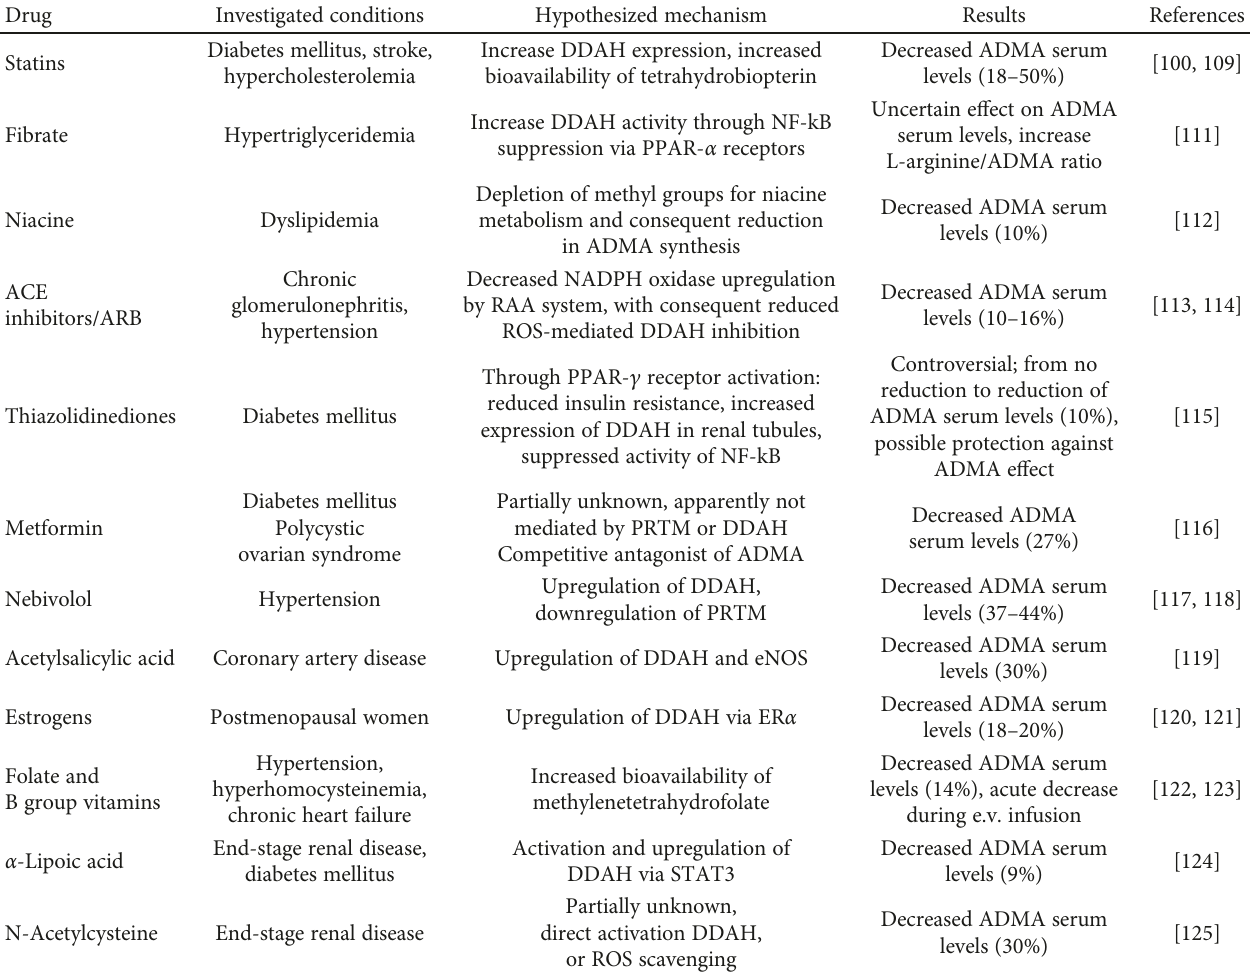
Table 2: ADMA lowering e ff ect and possible pharmacodynamic mechanism of di ff erent